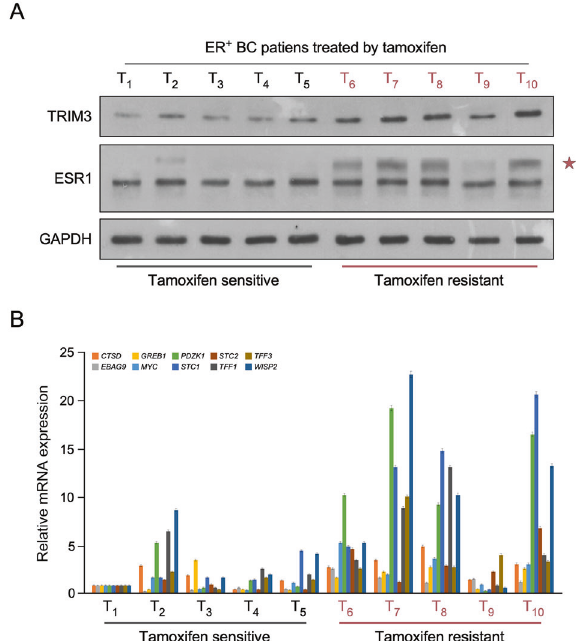
Fig. 6 TRIM3 promotes transcription of ER-target genes in clinical breast cancer. Western blotting of TRIM3 and ESR1 ( A ), qPCR of ER- targeted genes ( B ) in 10 cases of freshly ER + breast cancer treated with tamoxifen therapy, including tamoxifen-resistant and tamoxifen-sensitive tissues. GAPDH was used as the loading control. A star represents SUMOylation of